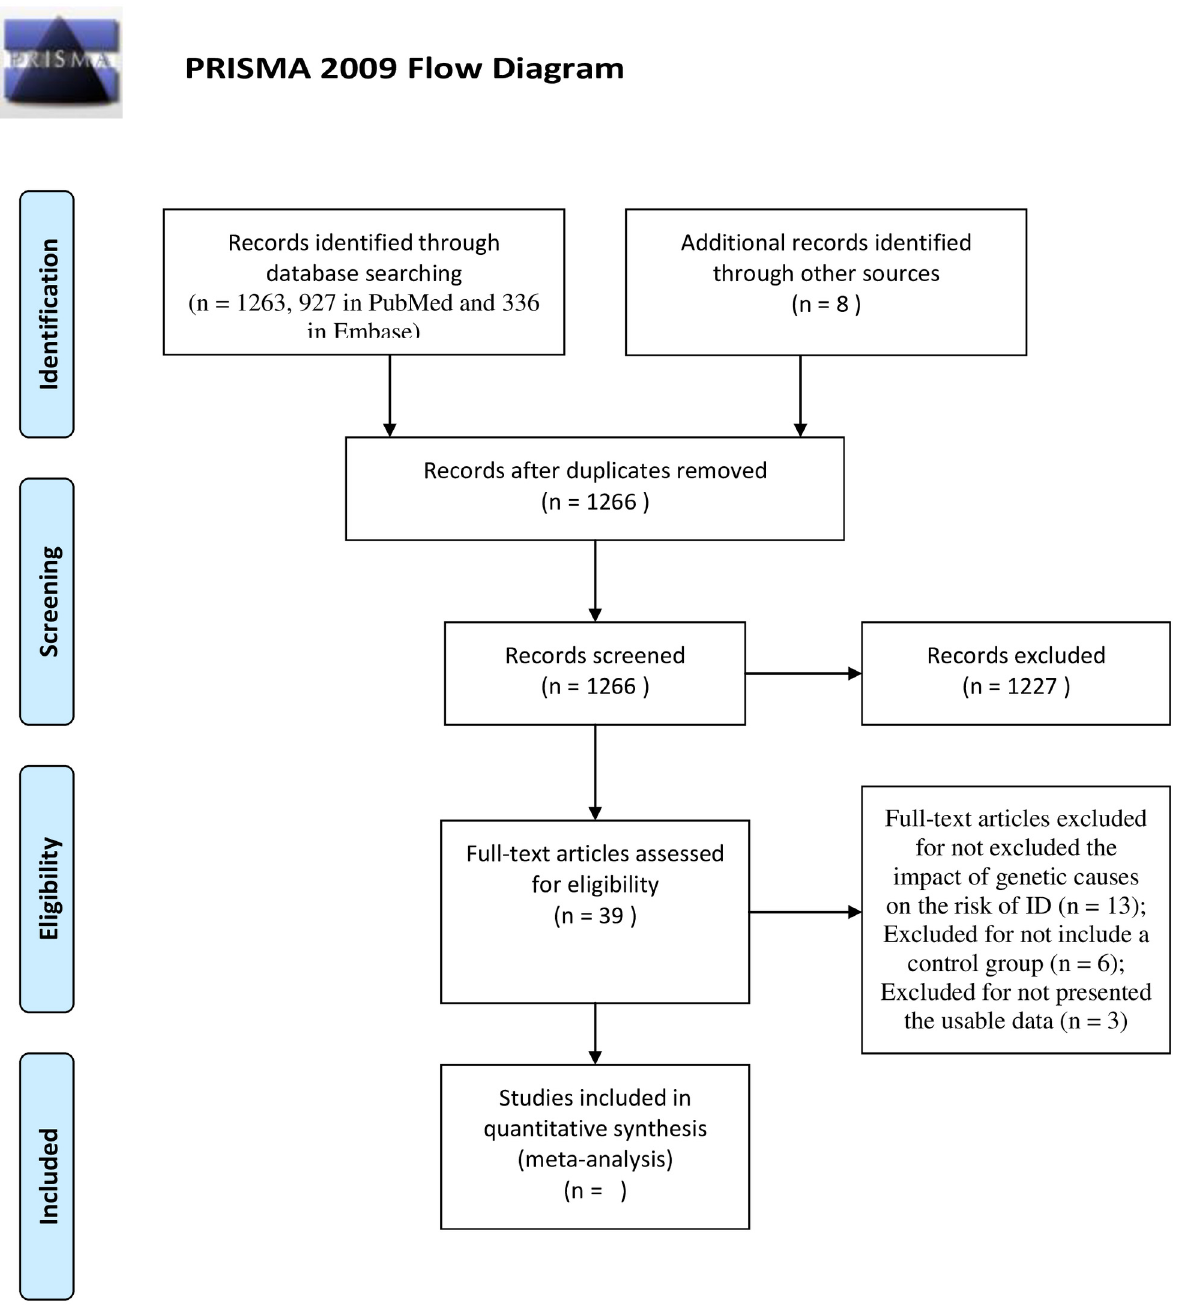
Fig 1. Flow gram of study selection